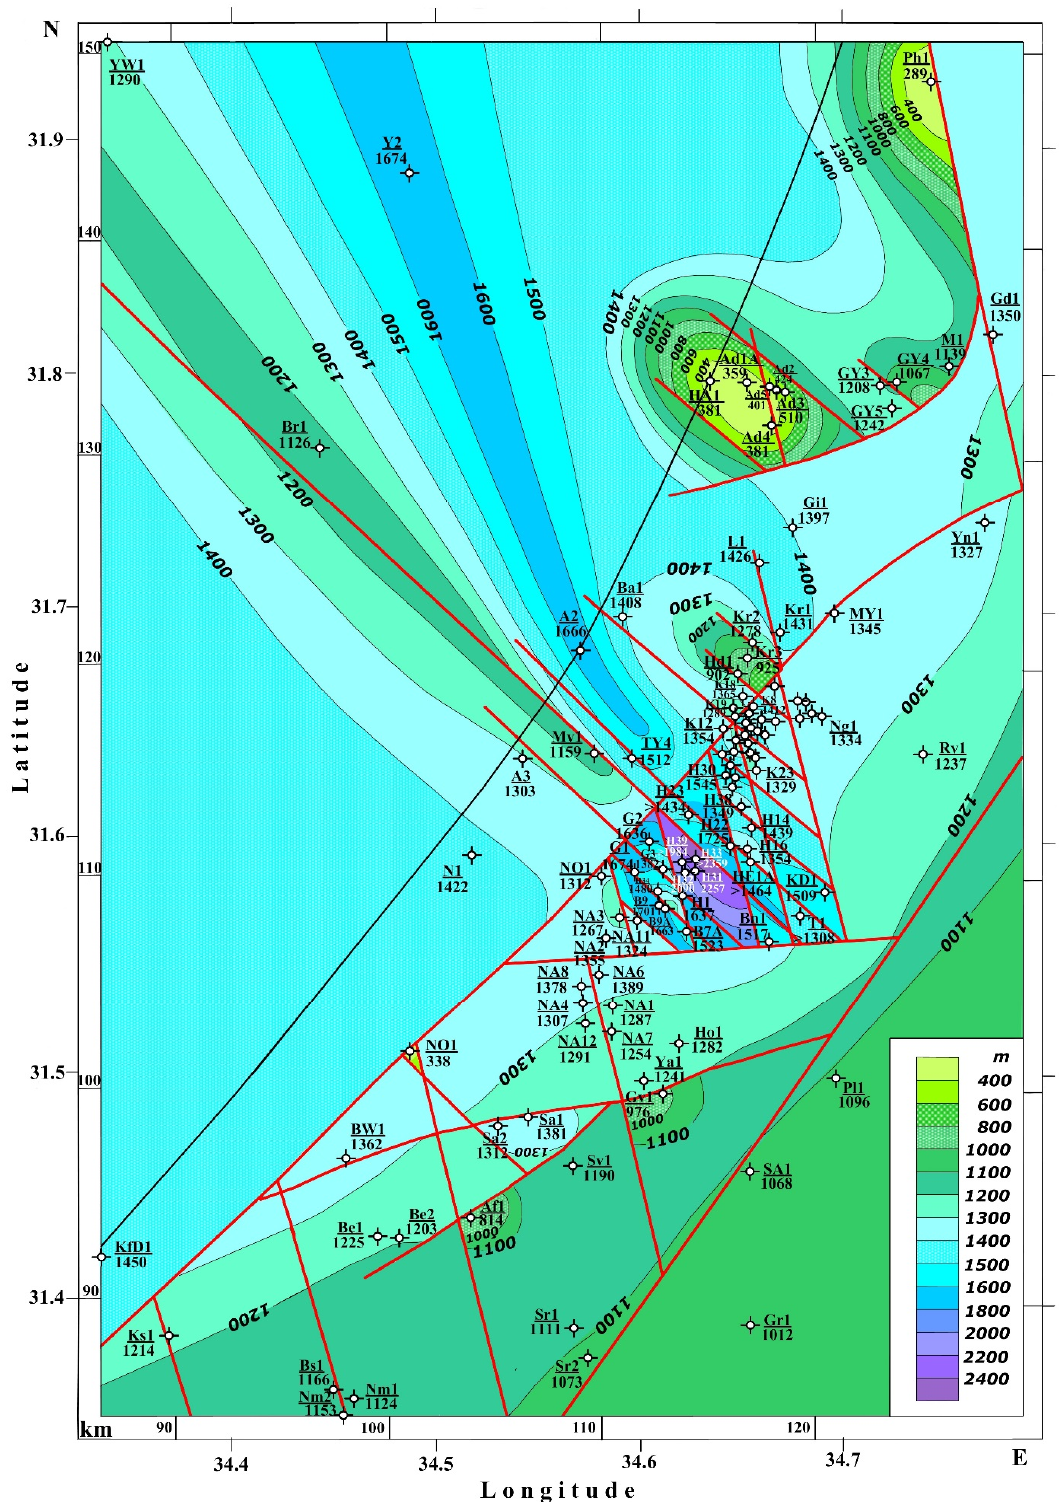
Figure 5. Early Cretaceous structural–paleogeographic map of the Heletz–Ashdod oil field and adjacent areas. Borehole abbreviations: see captions for Figure 2.